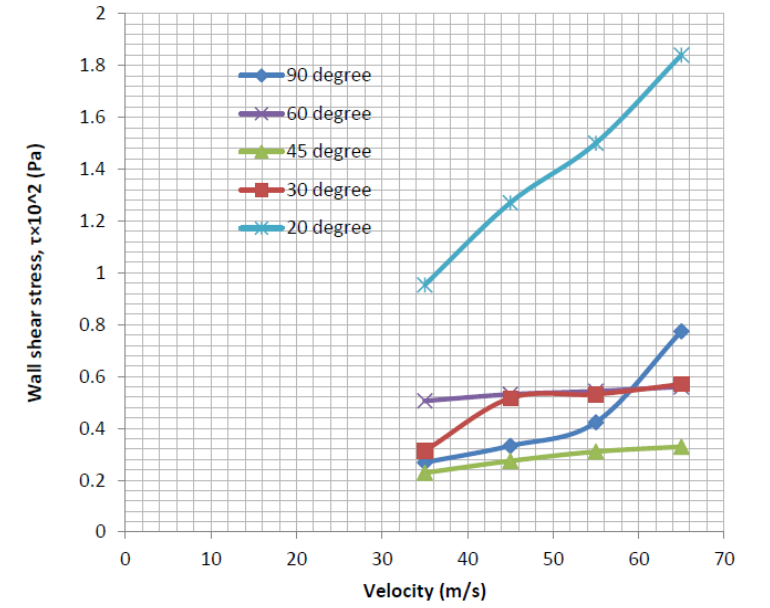
Figure 8: Wall shear stress vs. wind velocity curve for glass fibre resin at different angle of attacks